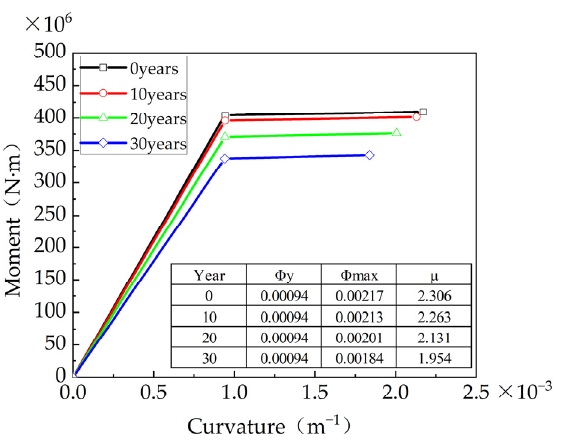
Figure 17. Bending moment curvature relationship of different corrosion structures.